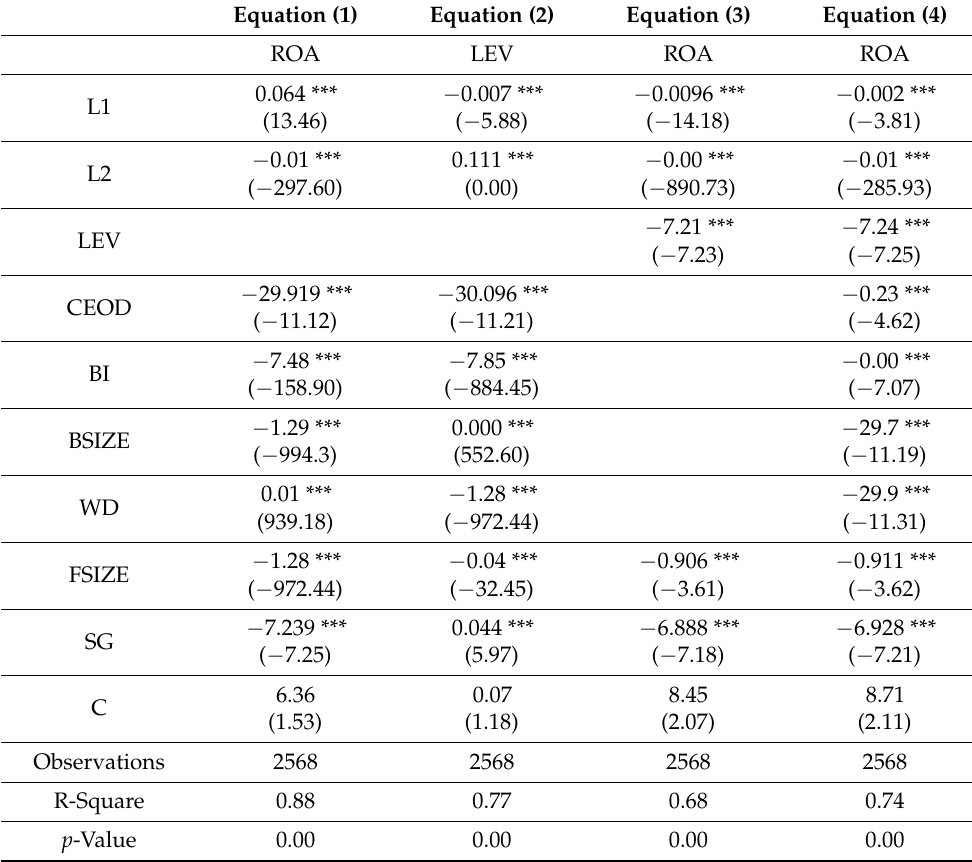
Table 6. Two -step system dynamic panel estimation across developed